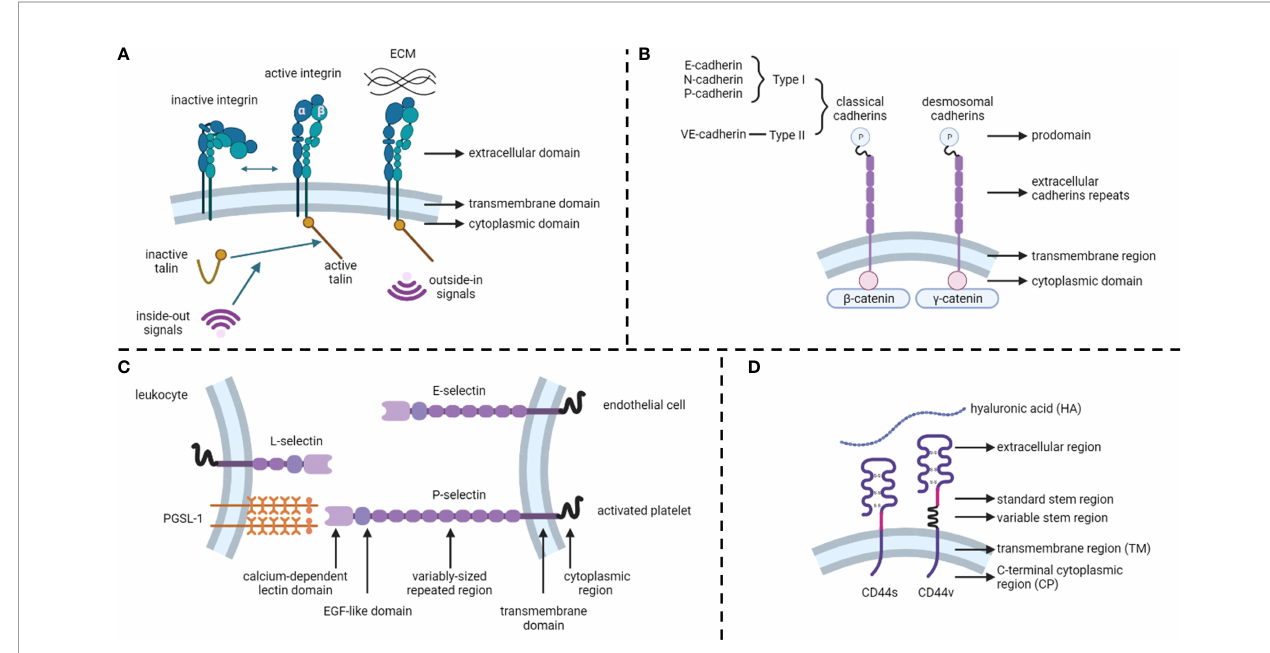
FIGURE 1 | Structures of cell adhesion molecules. (A) Integrins. (B) Cadherins. (C) Selectins. (D) CD44. ECM, extracellular